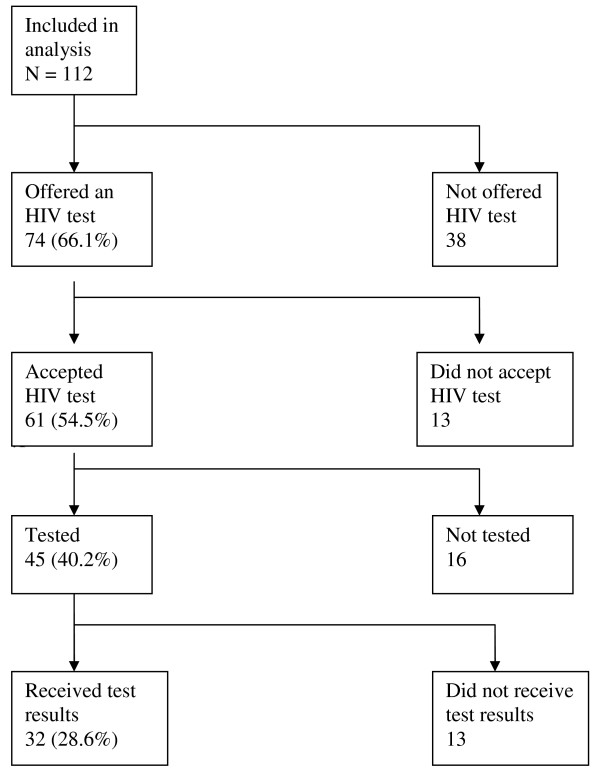
Flow chart showing the participants included in the analysis. Percentages refer to proportion out of 112.